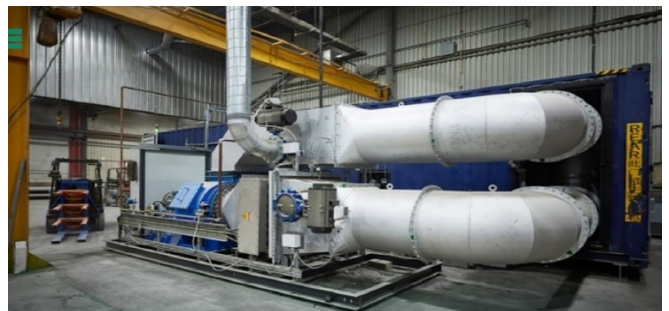
Figure 11. Container-chamber. Source: